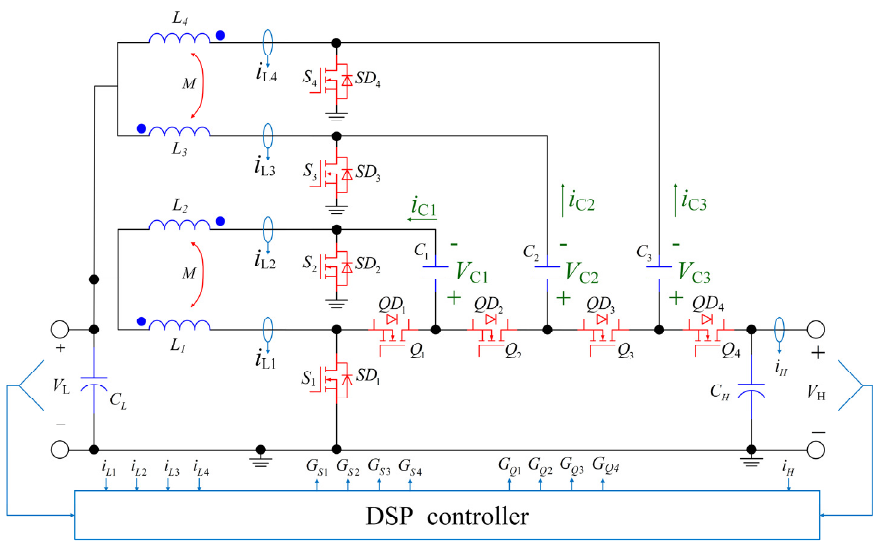
Figure 7. Schematic of the proposed four-phase HVCR